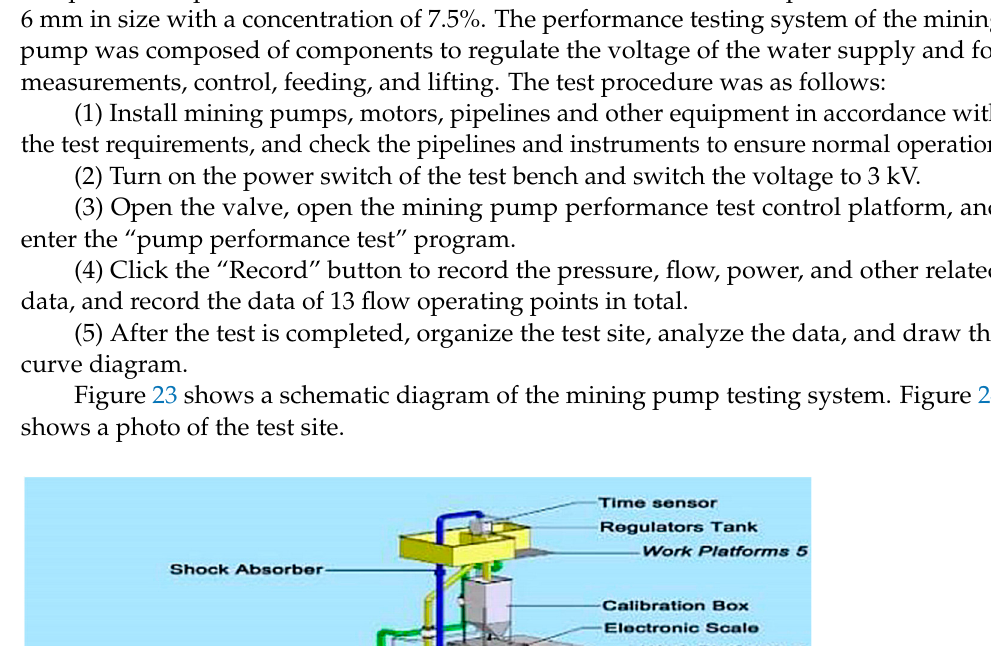
( c ) Figure 24. Test site: ( a ) mining pump test bench; ( b ) measurement and control system; ( c ) test particles. During the testing process, the head, shaft power, and efficiency of the mining pump were determined using the following formulas. The head was calculated according to Equation (16). The efficiency of the mining pump was calculated using Equation (22):